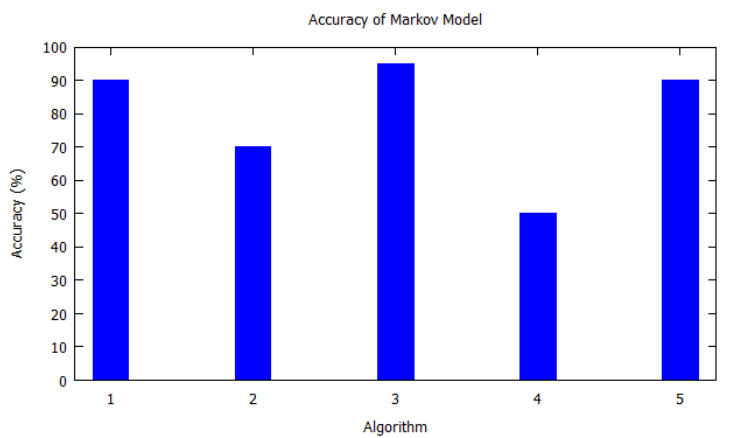
Figure 2. Accuracy of Markov model. Markov model as per Table 2 is shown with X -axis depicting the algorithms the paper used, i.e., the serial number from Table 2. Y -axis shows the accuracy of the algorithm that was used by the authors for that study.